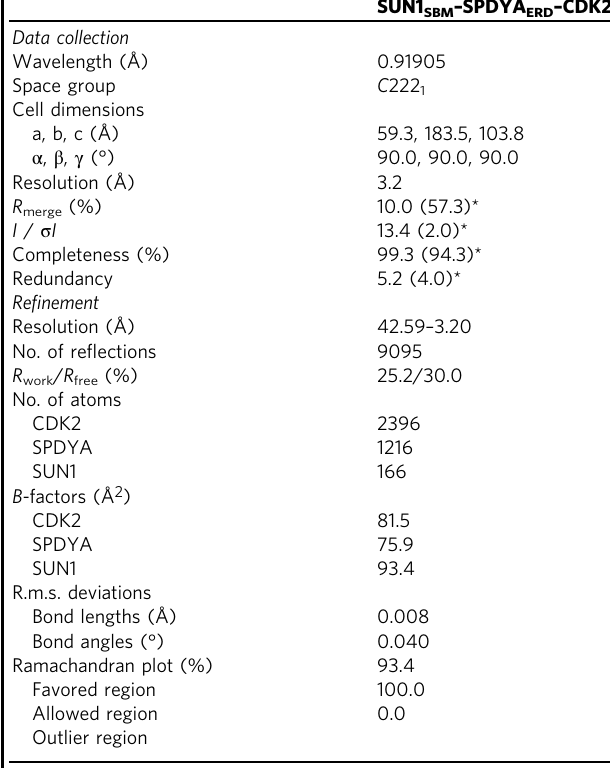
Table 1 Crystal data collection and re fi nement